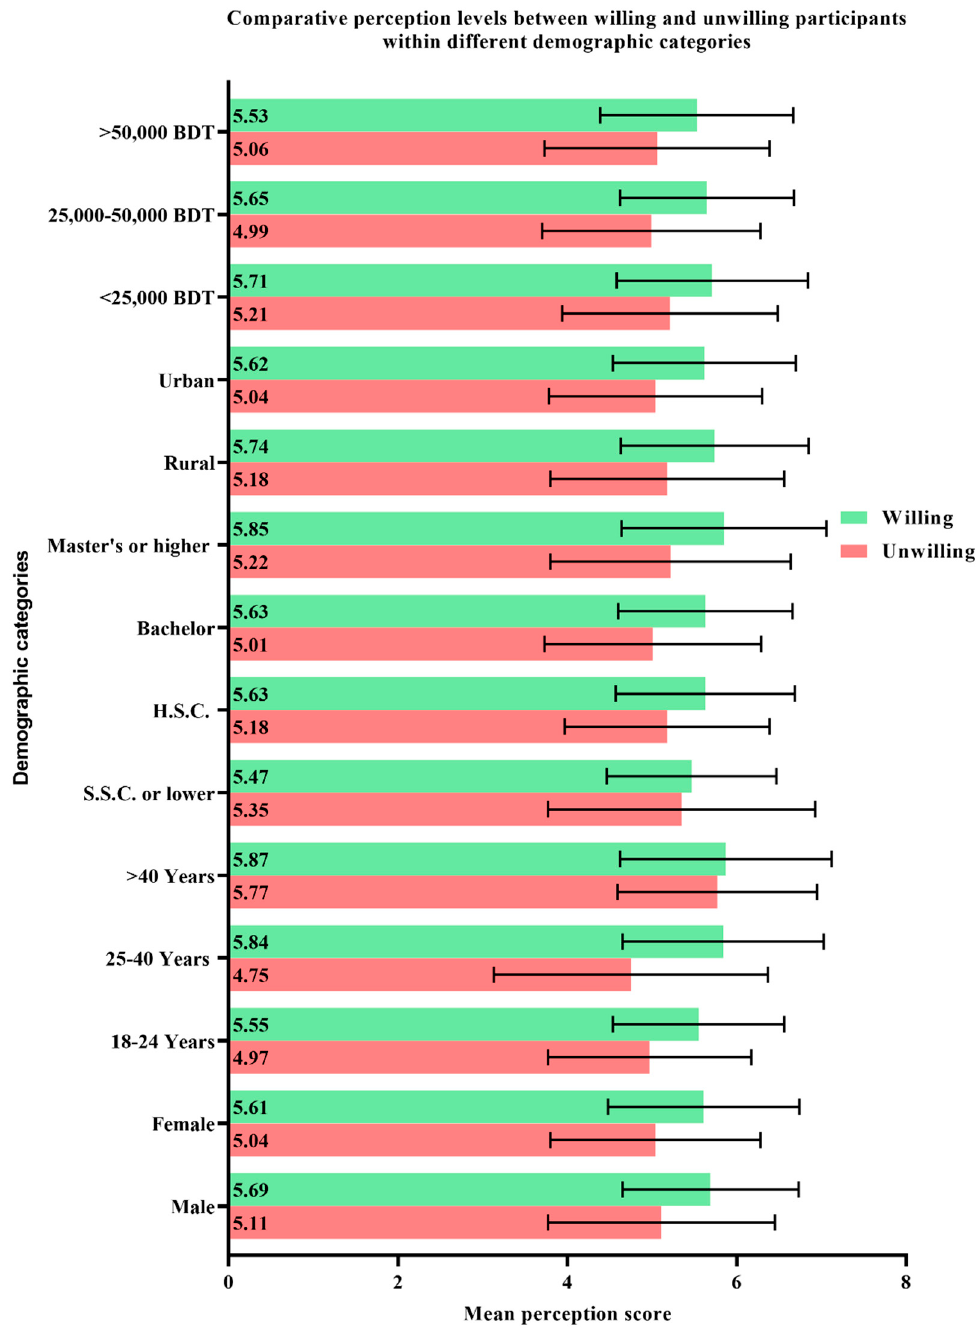
Figure 3. Comparative perception levels between willing and unwilling participants within different demographic categories expressed in terms of mean ± standard deviation.